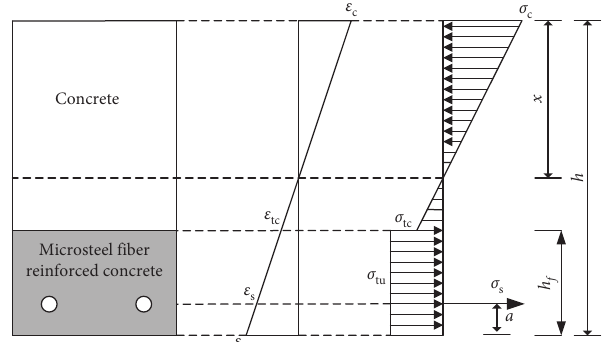
Figure 5: Cracking moment calculation diagram of normal